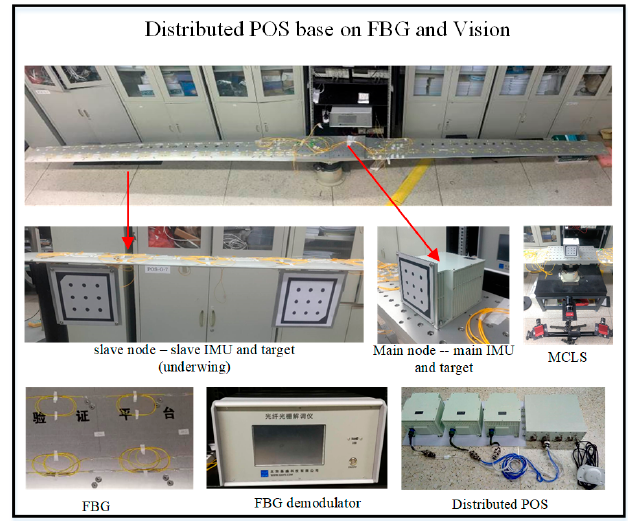
Figure 12. Composition of the test system.